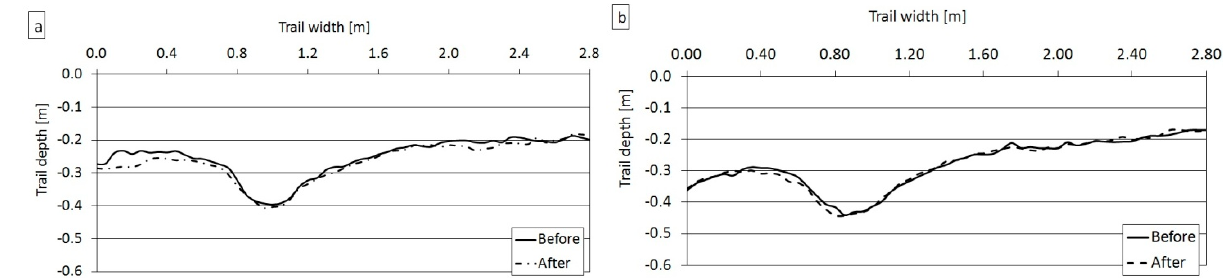
Figure 6. Topography on the trail sections before and after skidding: ( a ) Ht129U and ( b ) Ht129L.